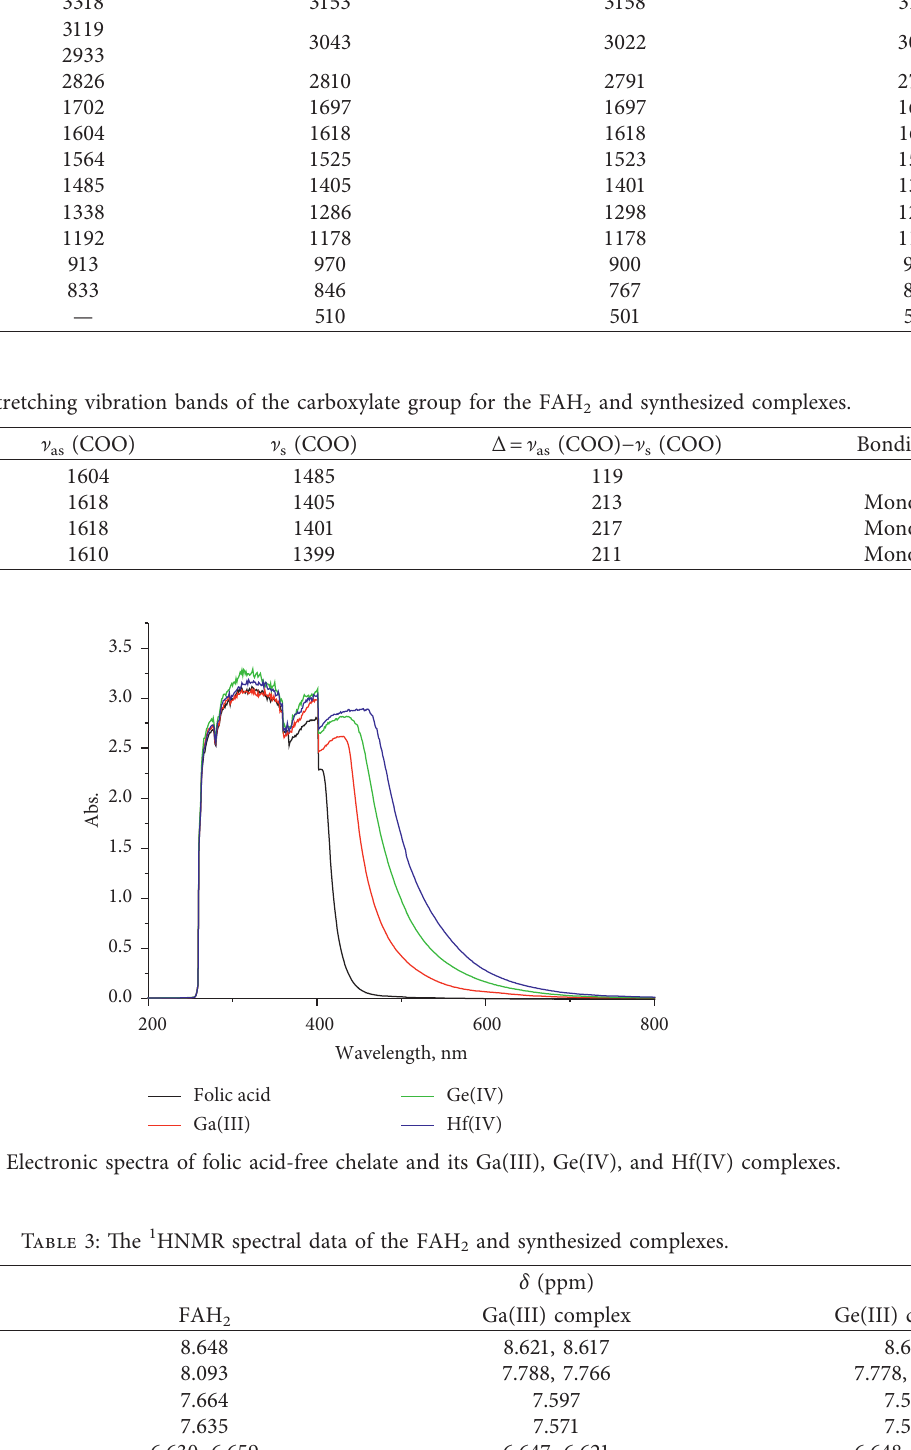
Table 1: Infrared spectral frequency data of FAH